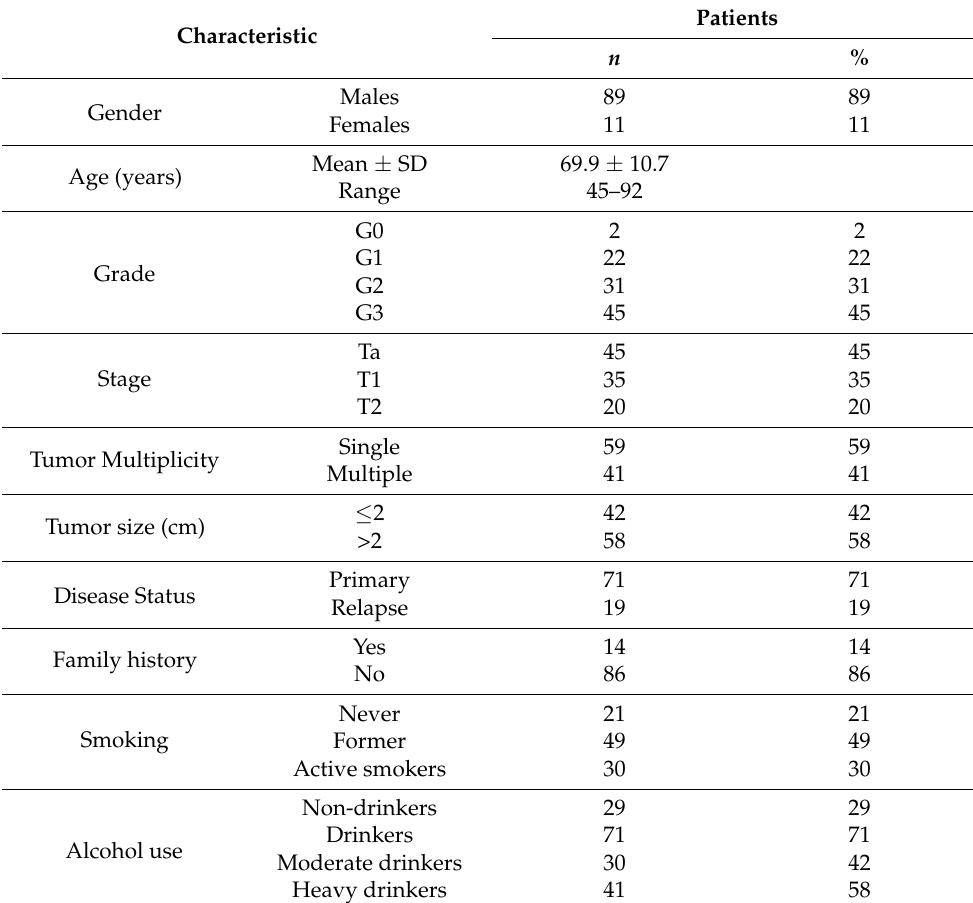
Table 1. Clinical and pathological characteristics of UCB